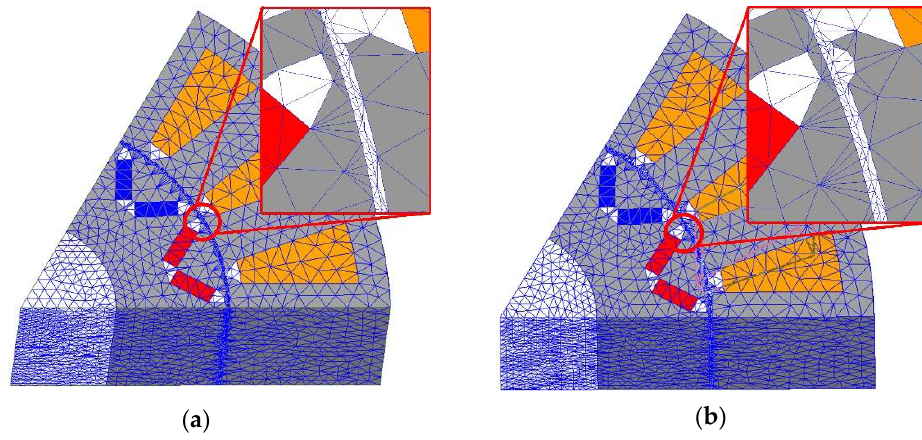
Figure 12. 3D mesh: ( a ) no wedge skew model; ( b ) wedge skew model.